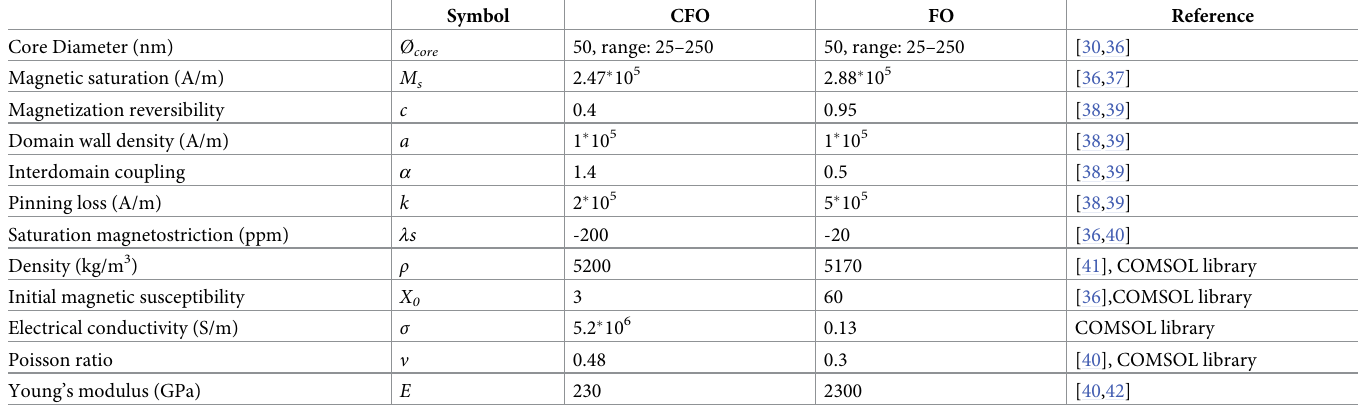
Table 1. MENPs core properties.